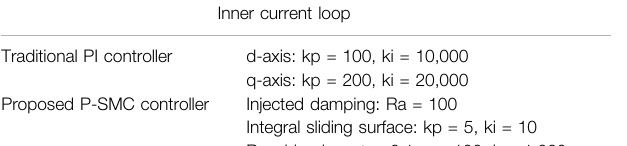
Figure 8B . The transmission line current is changed accordingly in Figure 8C to regulate the transmission line power.